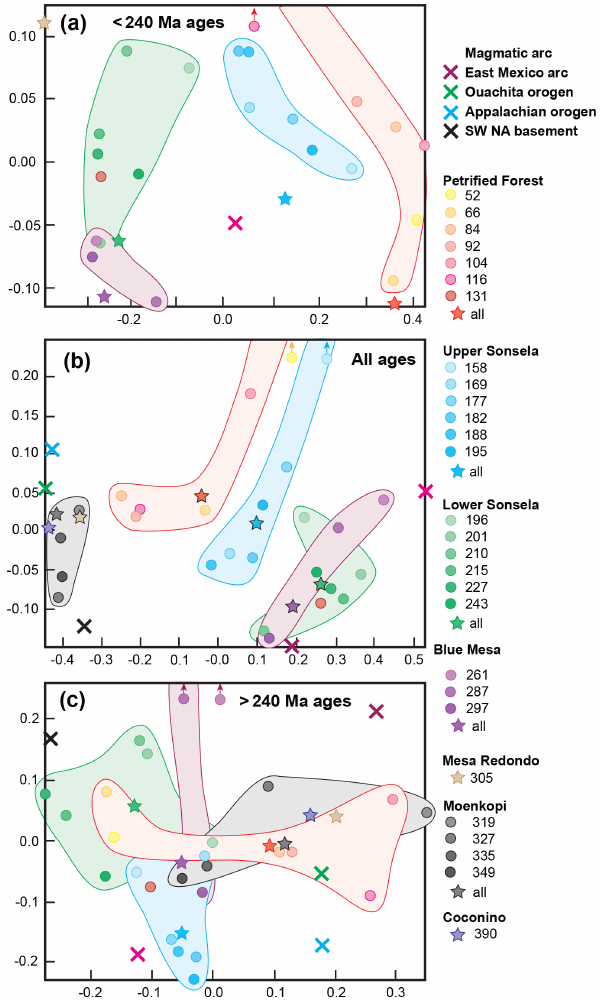
Figure 9. MDS plot (Vermeesch, 2013) comparing age distribu- tions of samples analyzed herein with each other and with possible source areas. MDS (metric) analyses were conducted using the soft- ware of Saylor et al. (2018). Data from samples analyzed herein are in Table S3. Ages for source regions are from the sources cited in the text. Stars represent MDS values for sets of examples, with the exception that sample 131-2 is not included with other Petrified For- est samples.